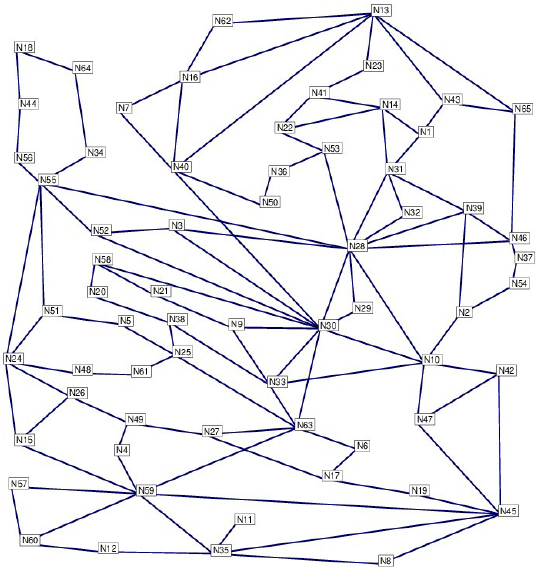
Figure 3. Topology of TA2